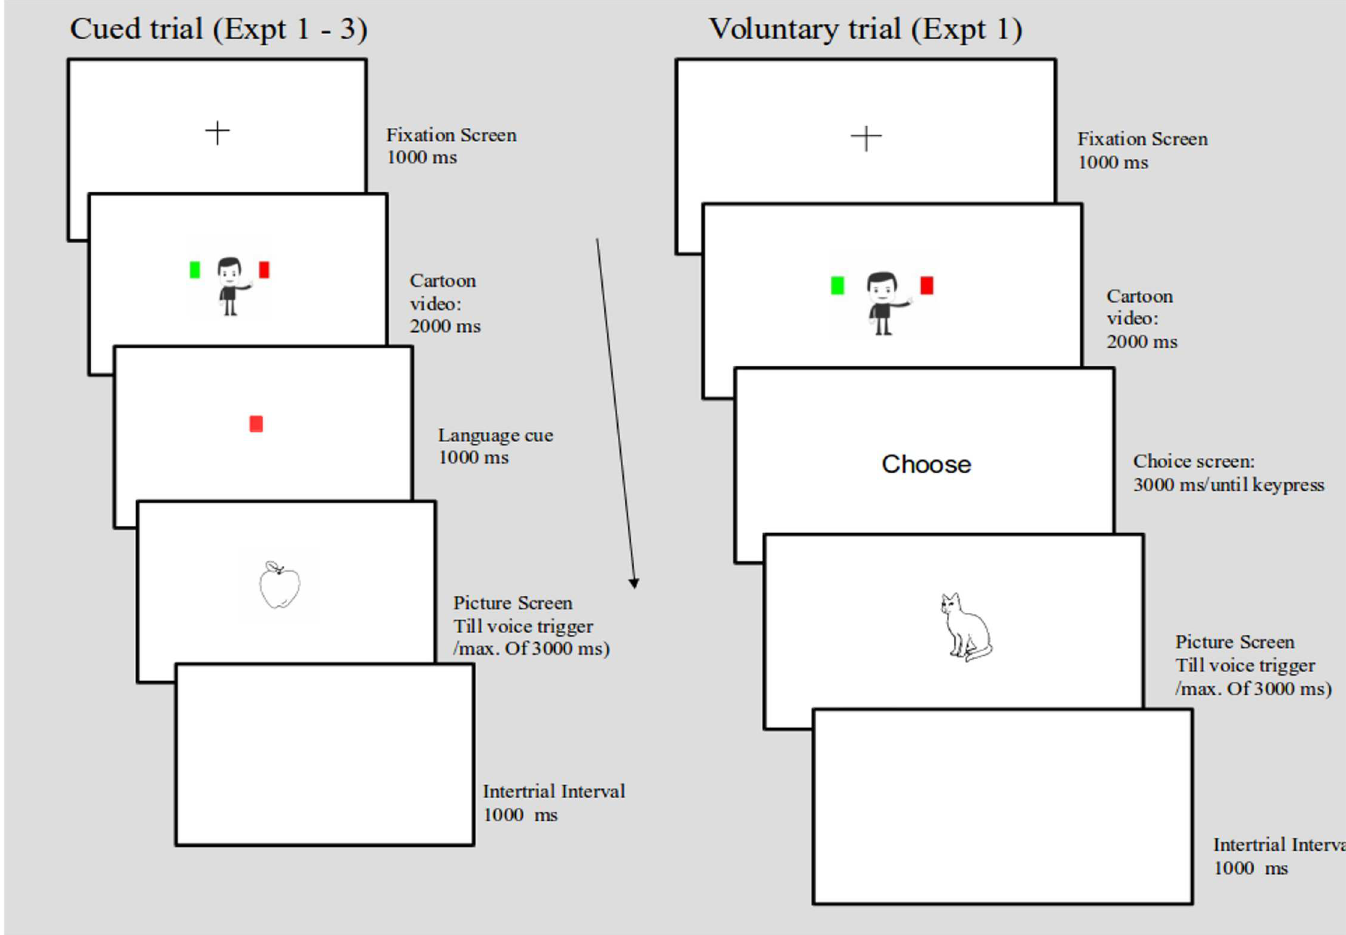
Fig 1. Sequence of events on cued trials (Experiment 1–3) and on voluntary trials (Experiment 1). The cued trial in this case refers to a congruent condition(cartoon wavingtowards “Red” matches the languagecue